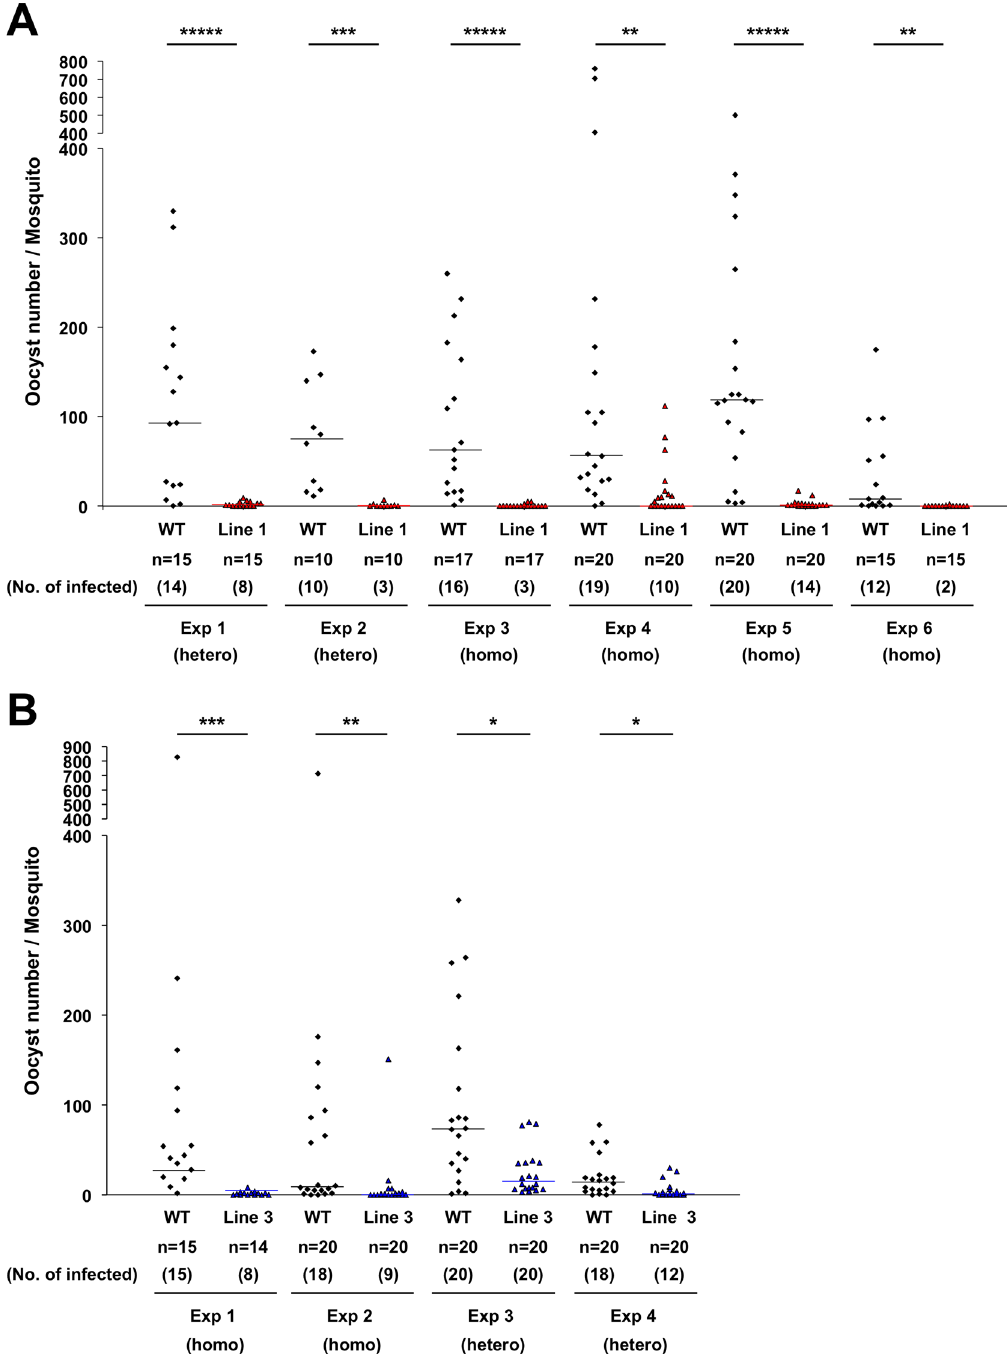
Fig 6. Oocyst numbers of P . berghei in wild-type and AAPP-mBax mosquitoes. Midguts were dissected 10 – 12 days after blood feeding and oocyst numbers were counted by microscopy. Homozygous and heterozygous transgenic mosquitoes were tested. (A) Results of line 1. Six independent experiments (Exp 1 – 6) were shown. (B) Results of line 3. Four independent experiments (Exp 1 – 4) were shown. The status of transgenic mosquitoes (homozygous or heterozygous) is represented below the numbers of the experiment. These experiments were performed using separate generations of mosquitoes. ( ***** : P < 0.000001, *** : P < 0.0001, ** : P < 0.001, * : P < 0.01, calculated by the Mann-Whitney U test). The line shows the median.